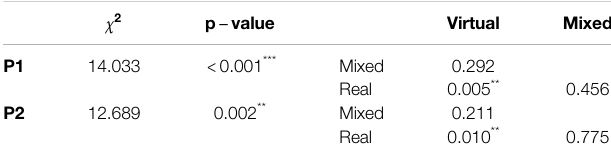
TABLE 5 | Signi fi cant differences found in the post-experiment questionnaire results across tested environments.